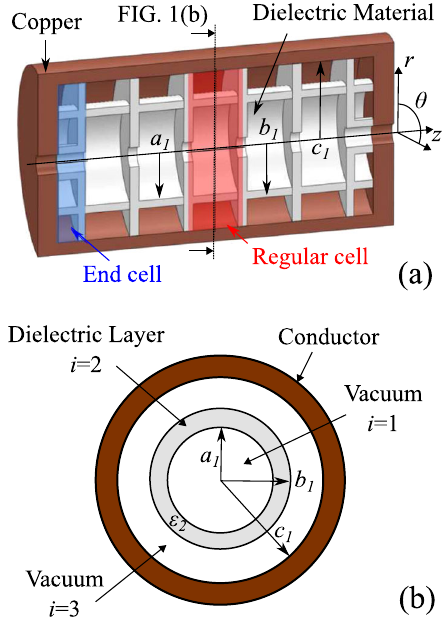
FIG. 1. Conceptual illustrations of a DAA structure. (a) Longi- tudinal cross section of the 5 cell prototype design of the DAA structure. (b) Cross section of the DAA structure perpendicular to the beam direction and parallel to dielectric disks at the center of the regular cell. The symbol “ i ” denotes the index of regions (vacuum or dielectric regions) running from 1 (center) through 3